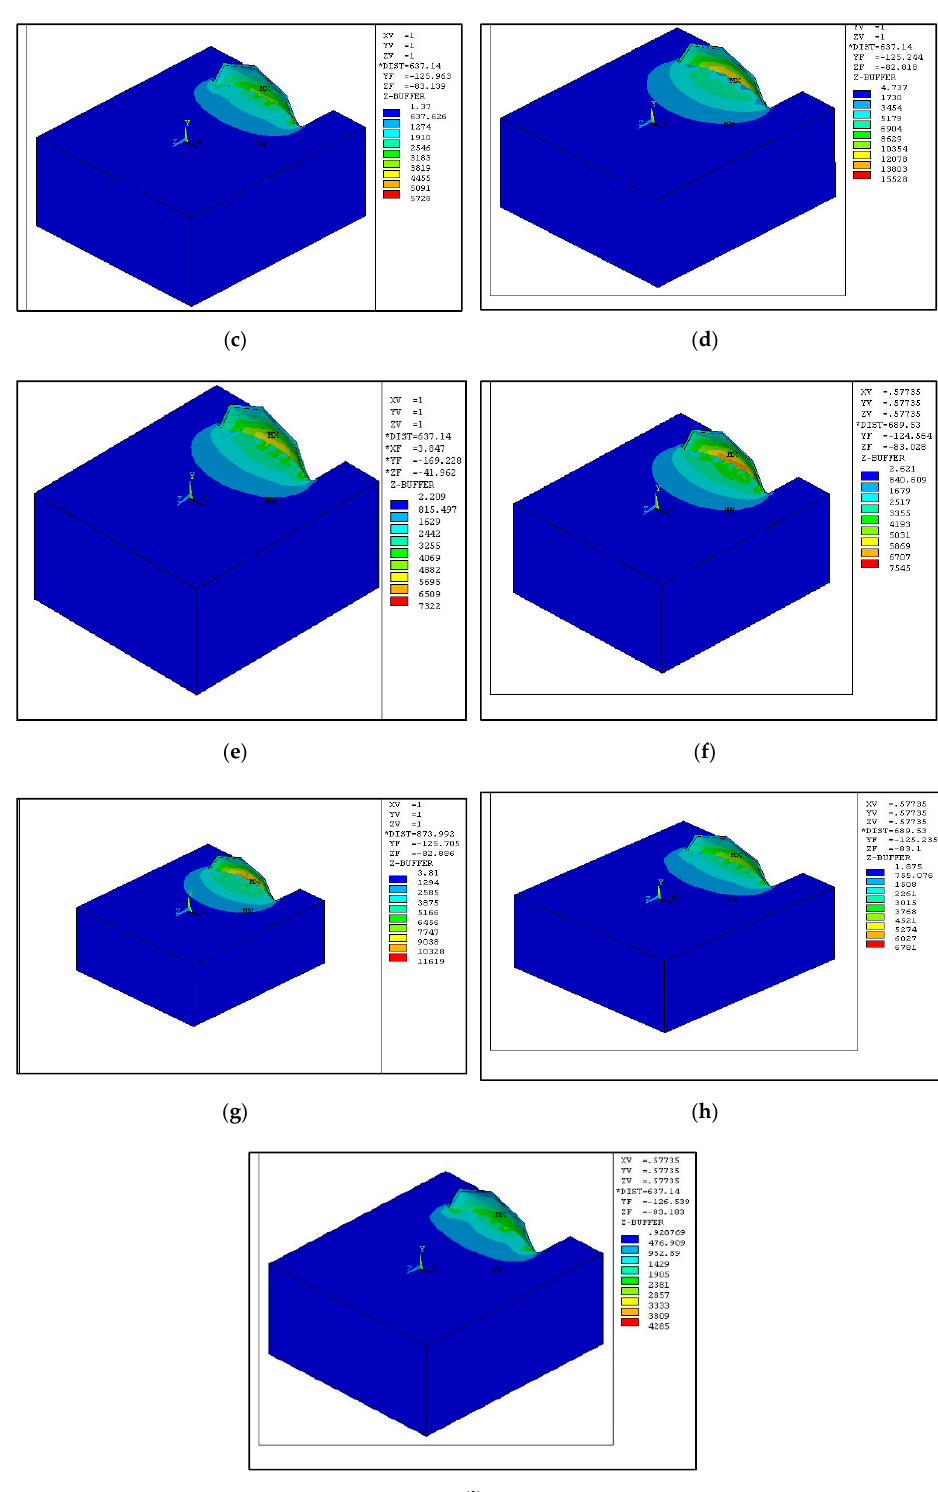
Figure 7. Von Mises Stress. ( a ) to ( i ): ( a ) Biomimetic disc (0% convex dome density which is basically the plain disc for control); ( b ) Biomimetic disc (1 mm deep, 10% concave dome density); ( c ) Biomimetic disc (3 mm, 30% concave hollow density); ( d ) Biomimetic disc (1 mm, 10% convex dome density); ( e ) Biomimetic disc (1 mm, 30% concave hollow density); ( f ) Biomimetic disc (3 mm, 10% concave hollow density); ( g ) Biomimetic disc (1 mm, 10% convex dome density); ( h ) Biomimetic disc (1 mm, 30% convex dome density); ( i ) Biomimetic disc (3 mm, 10% convex dome